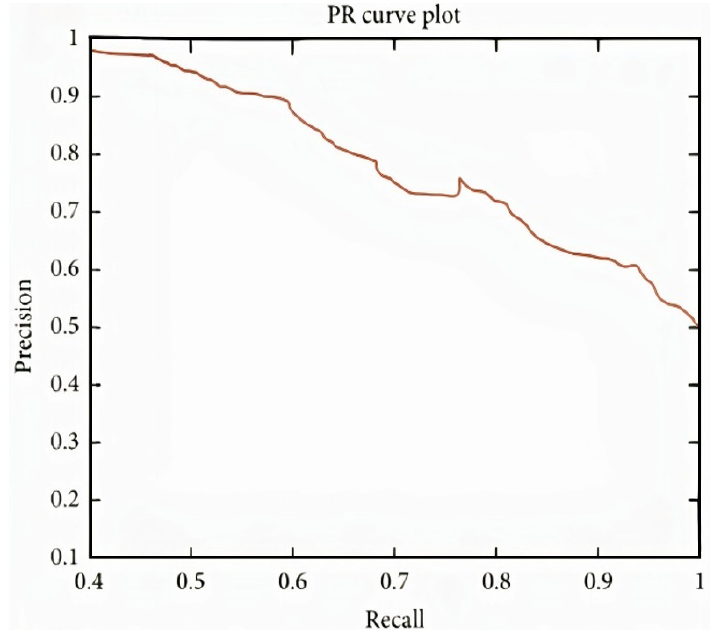
Figure 22. PR curve of liking label.